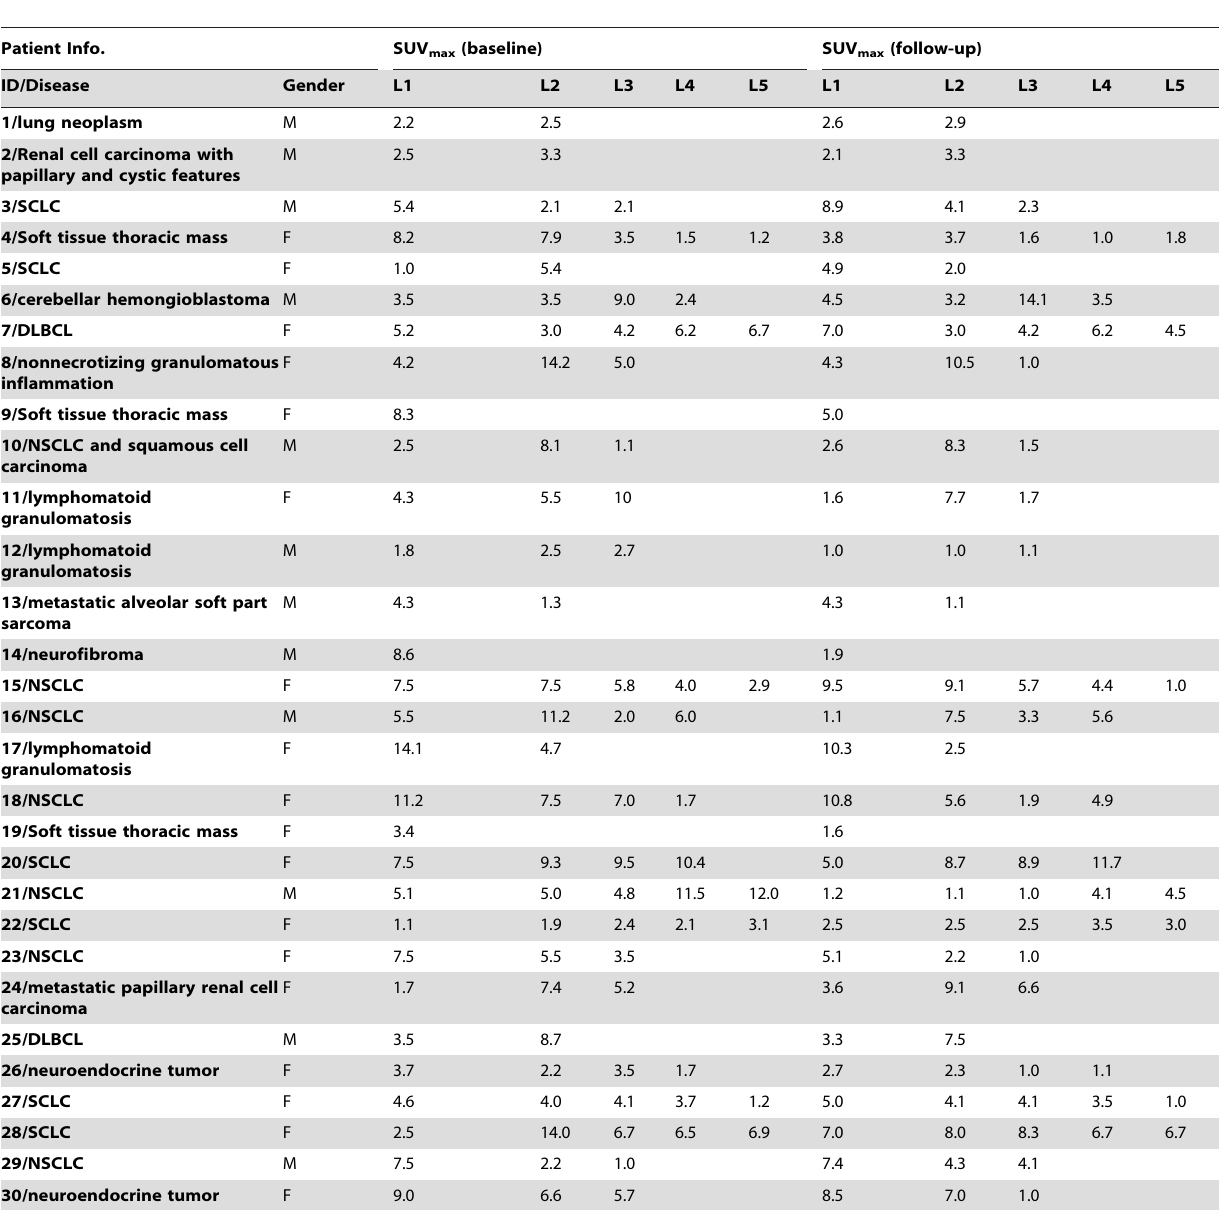
Table 1. Patient demographics with gender information; SUV max values corresponding to lesion numbers (denoted by L # ) both for baseline and follow-up scans are enlisted.